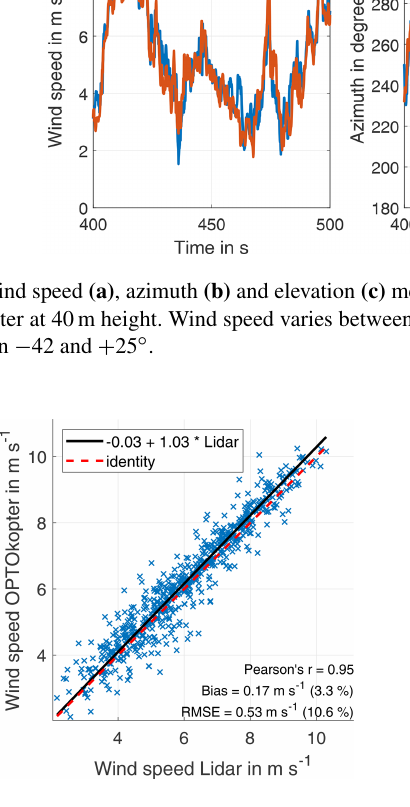
Figure 14. Linear Deming regression of the UAV wind speed mea- surement at 40m height for 1s averaging interval. The PTB lidar is used as a reference